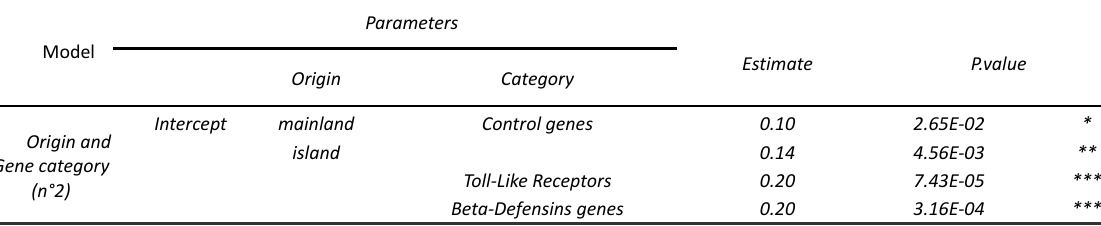
Table 3: Summary of the model n°2, best statistical model selected using AICc explaining variation in Pn/Ps in control genes, Toll-Like receptors and Beta-Defensins genes under purifying selection with origin, gene category parameters. * indicates significant values : * < 0.05; ** < 0.01; *** < 0.001.